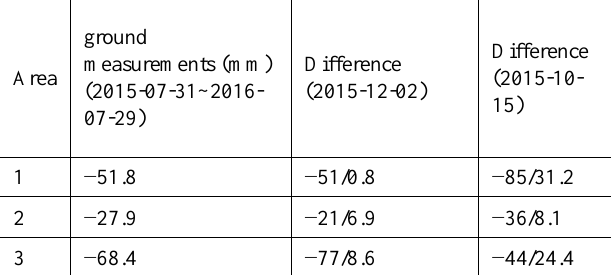
Table 4. Comparison of accuracy between PS-InSAR and level monitoring results